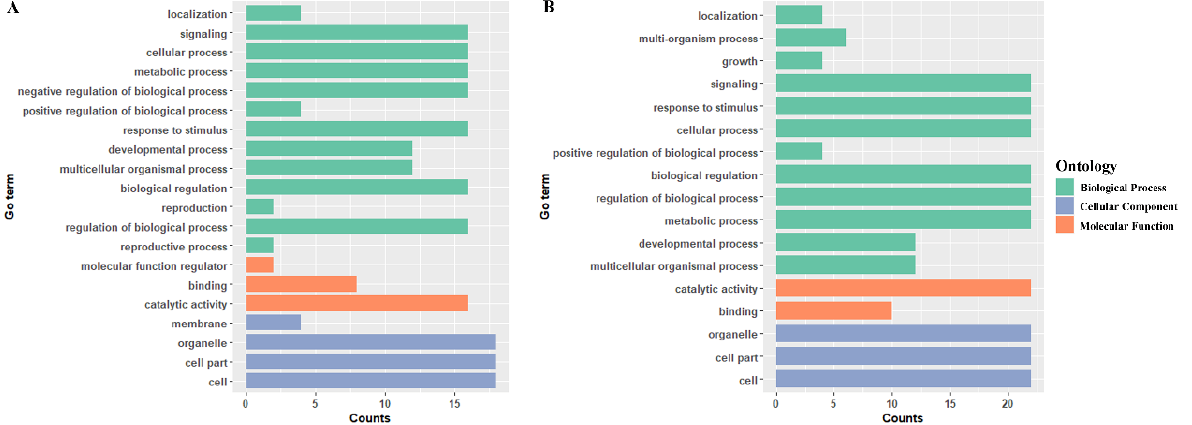
Figure 6. GO enrichment analysis. ( A ) GO enrichment of GmPP2C-A genes. ( B ) GO enrichment